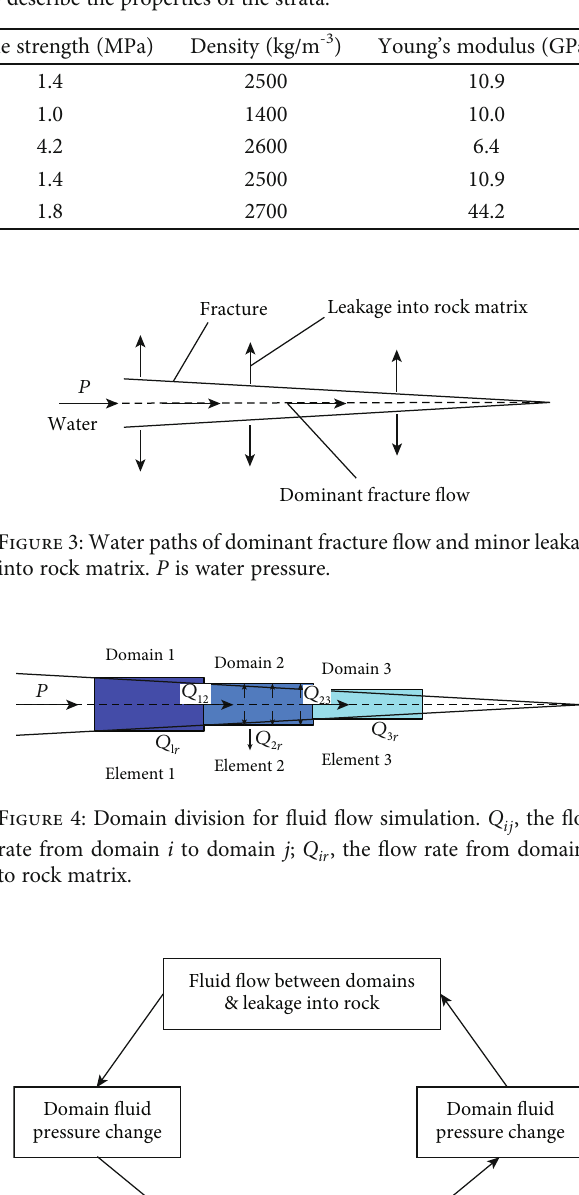
Figure 5: A coupled F-H